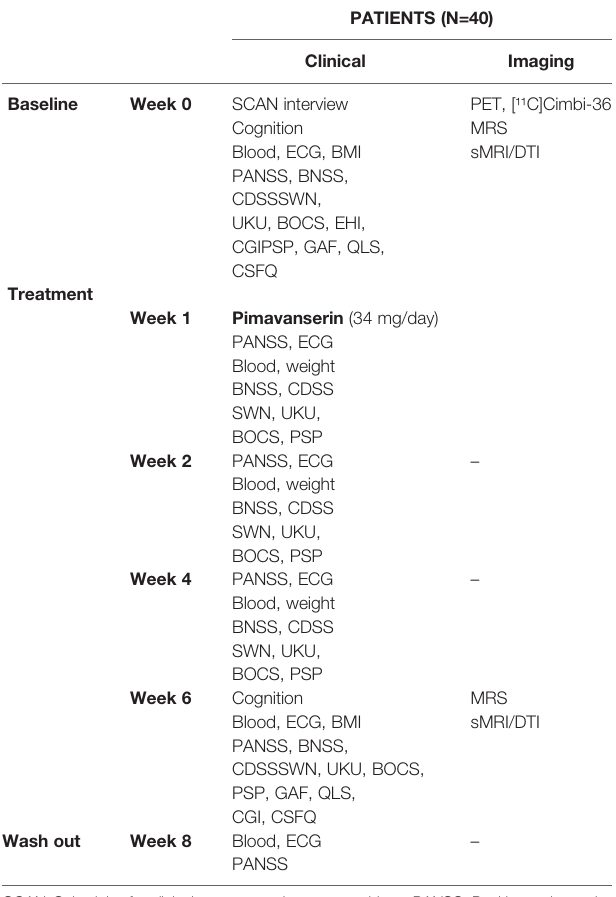
TABLE 2 | Examination Program of the Sub-Sero Study.